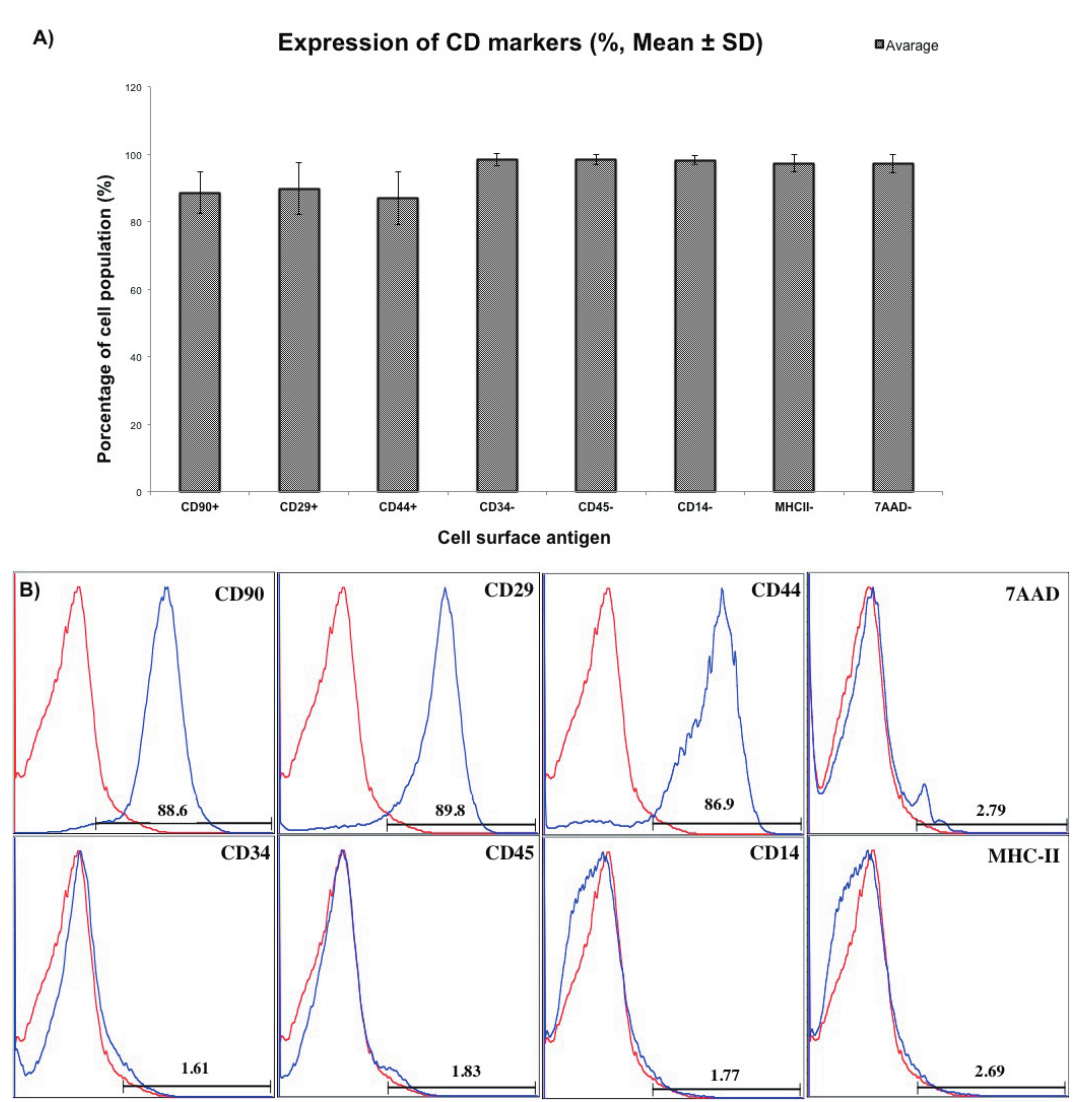
Figure 4- A) Immunophenotypic analysis. Each value is the mean percentage of the twelve samples ± standard deviation of BM-pMSCs, which were tested for each cell surface antigen expression. B) BM-pMSCs were labeled with antibodies against the indicated antigens and analyzed by flow cytometry. Representative histograms are displayed. On the y axis, there is the % max (the cell count in each bin divided by the cell count in the bin that contained the largest number of cells), and the x axis is the fluorescence intensity in a log (100–104) scale. The isotype control is showed in red, and blue histogram indicates reactivity with the antibody